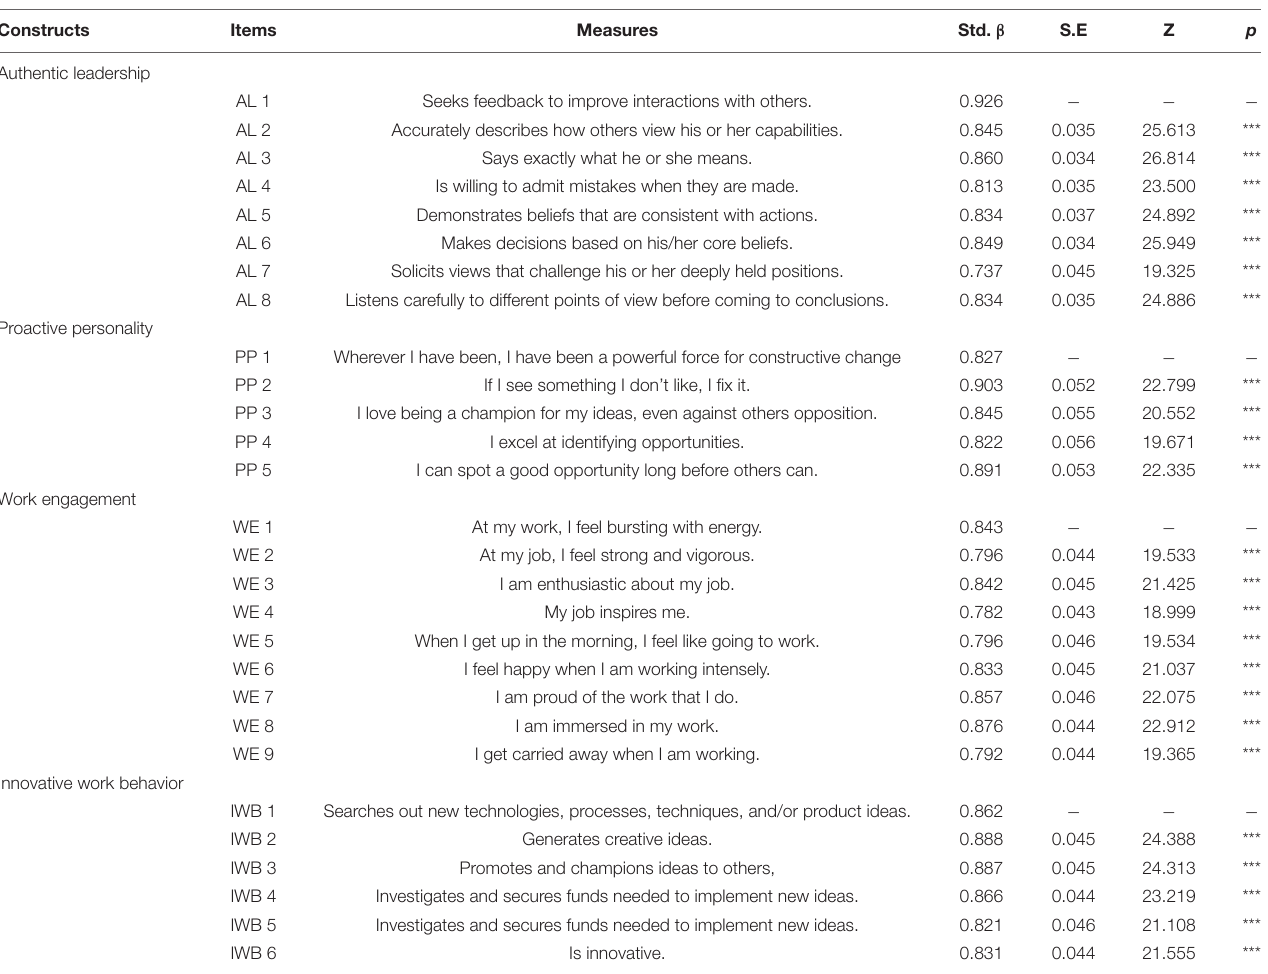
TABLE 1 | Measurement model analysis.